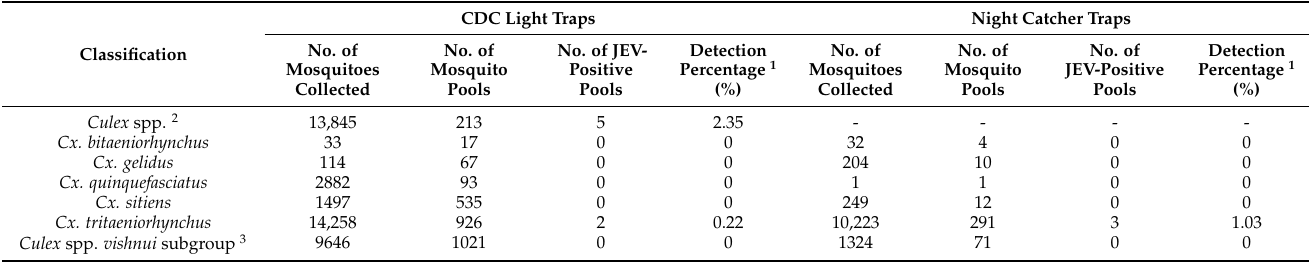
Table 1. Field-caught Culex mosquitoes in the present study. See Table S2 for more details on the distribution of mosquitoes in the present study.